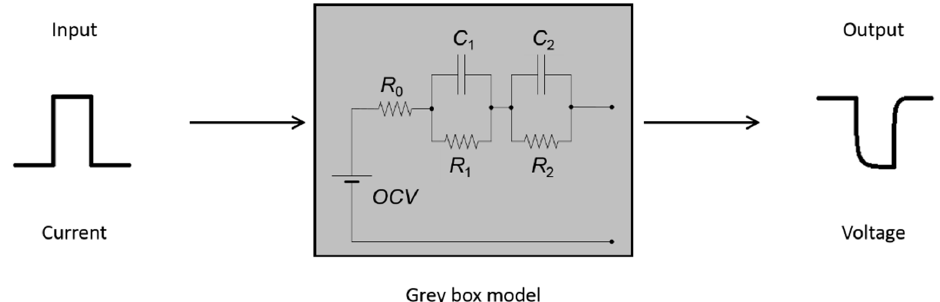
Figure 3. Typical equivalent circuit model (ECM) input/output behaviour.